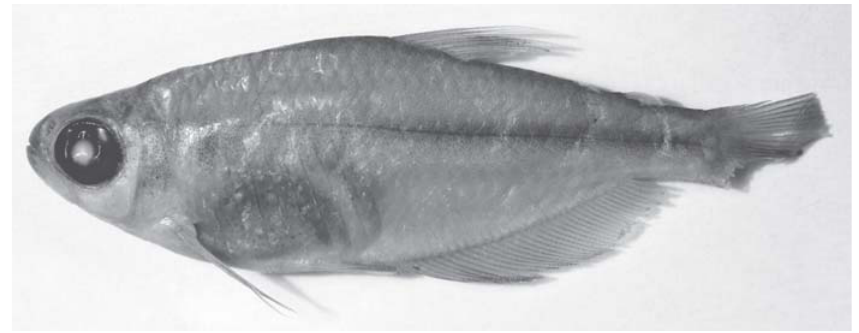
Fig. 3. Syntype of Hyphessobrycon melanopleura uruguayensis Messner, 1962. MHNM 758, possibly a male due to the large convexity of the anal fin, 35.3 mm SL.